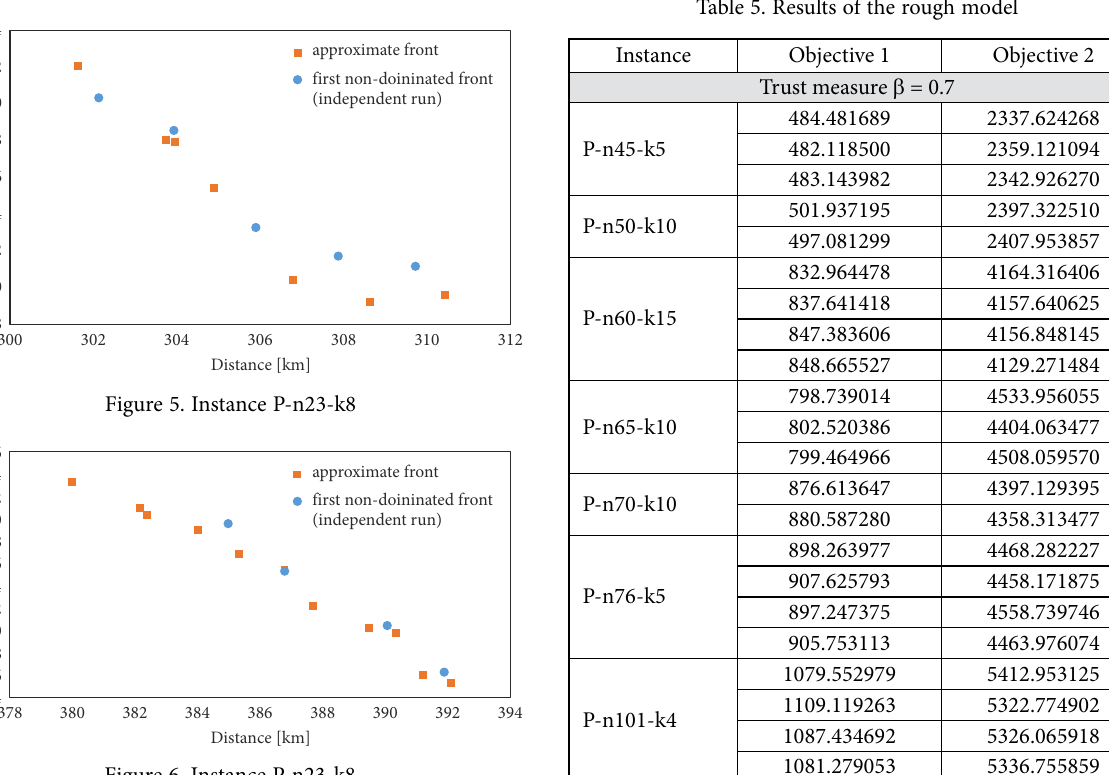
Figure 4. Instance P-n45-k5